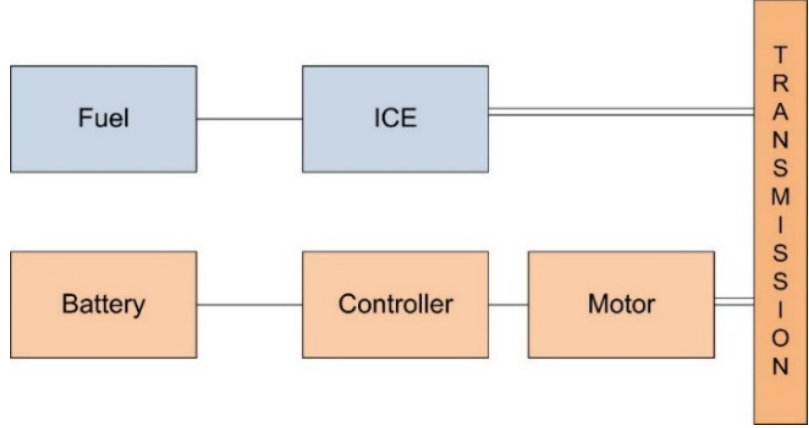
Figure 1. Architecture of parallel HEV.